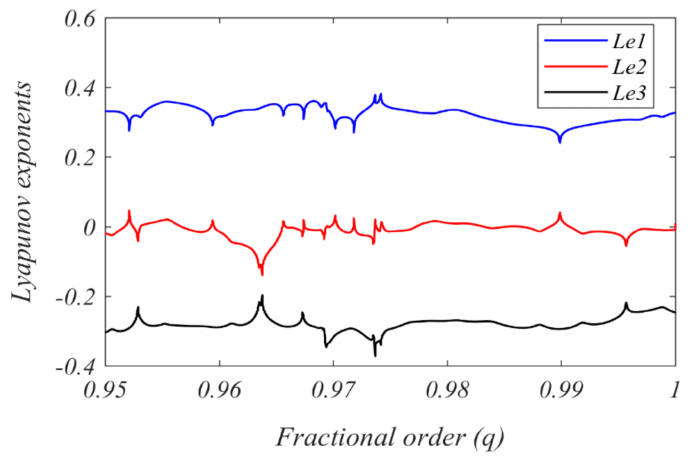
Figure 6. Lyapunov exponents corresponding to the system in Equation (5) fractional order ( q